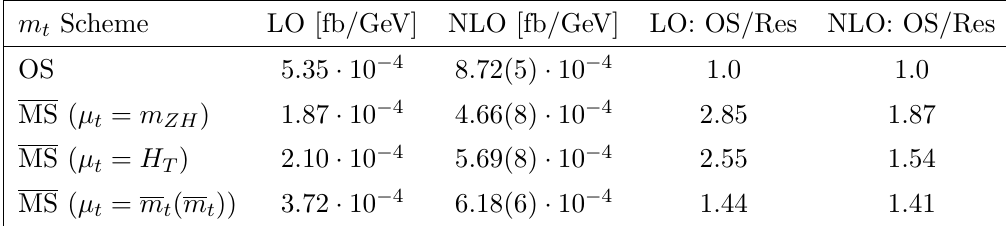
Table 2. The LO and NLO results in various top quark mass schemes for bin m = [1000 , 1020] GeV . The rightmost columns show the ratio of the on-shell result to ZH results in other mass schemes at LO and NLO in this bin, respectively. Transverse momentum cuts of p 140 GeV and p 150 GeV are applied and the remaining scales are set to T,H ≥ T,Z ≥ µ R = µ F = m ZH